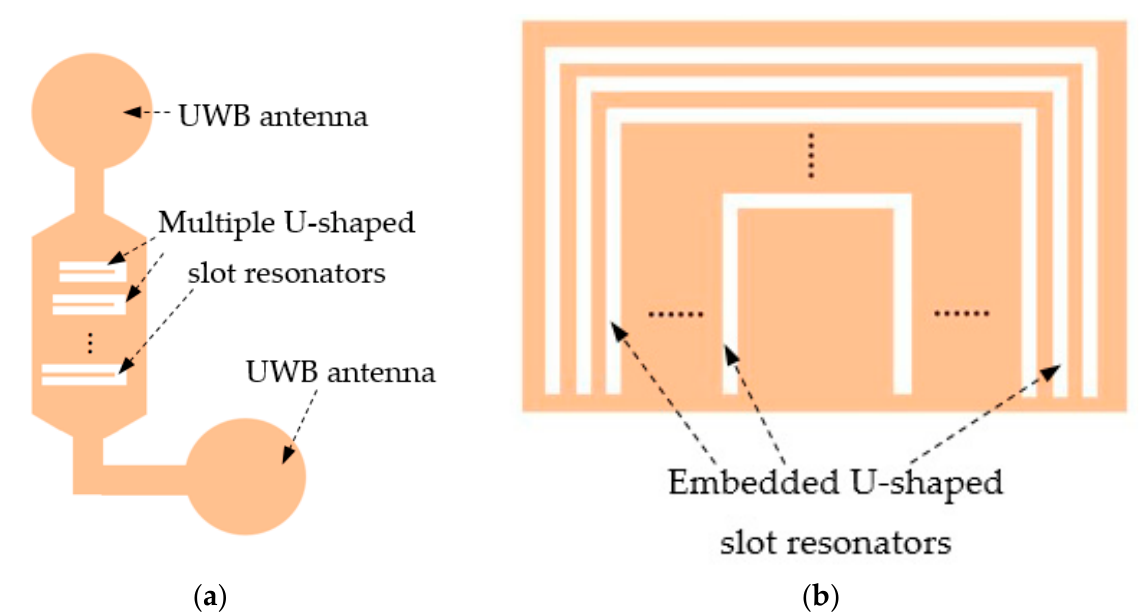
Figure 13. ( a ) Schematic of the designed tag based on the retransmission chipless tag; ( b ) the structure proposed by Islam which used embedded U-shaped slots based on self-resonance.